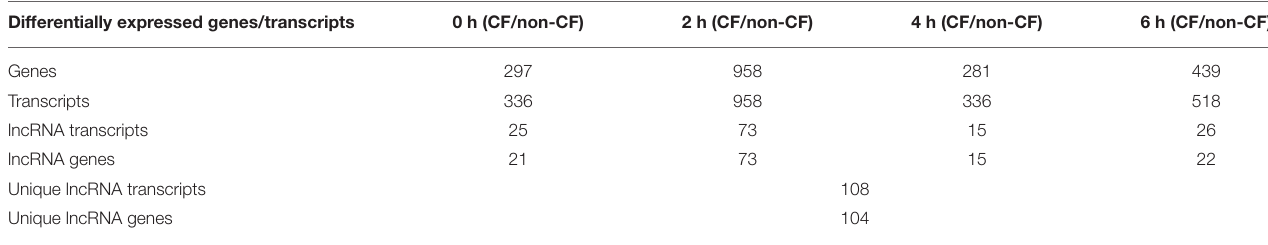
TABLE 1 | Summary of genes and transcripts differentially expressed in CF vs. non-CF cells at each time point of infection. Differentially expressed